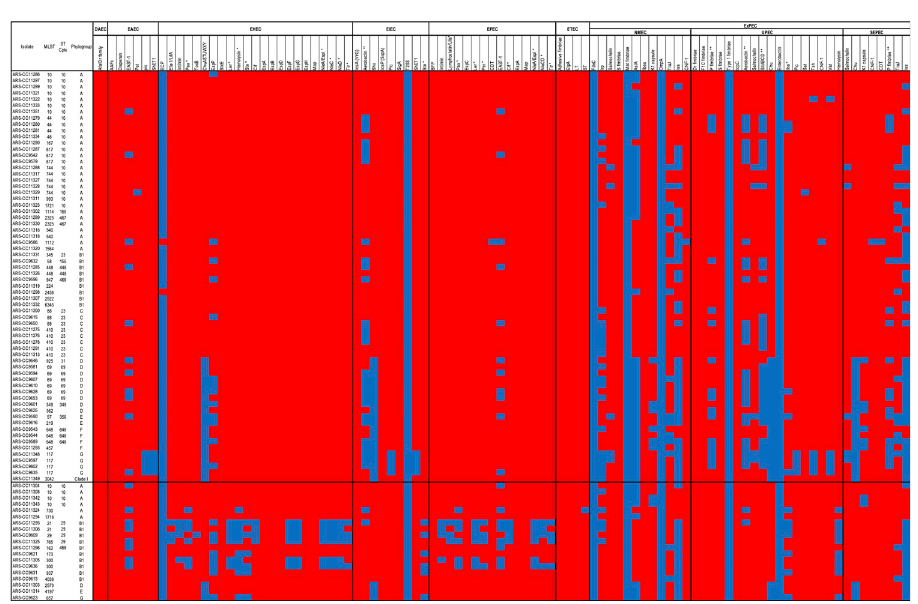
Fig 3. Virulence factors detected in MDR and susceptible isolates. Blue box = present. Red box = absent. � = more frequently detected in susceptible isolates. �� = more frequently detected in MDR